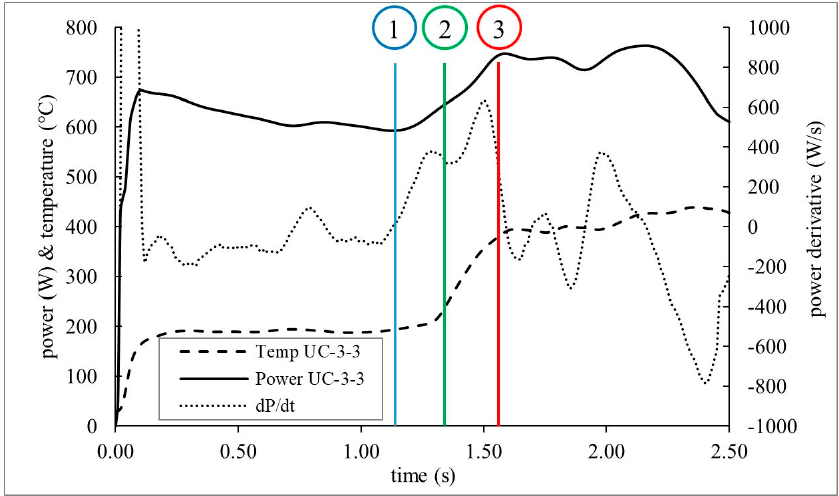
Figure 9. The time traces of the power, temperature, and the power derivative for the uncontrolled weld case C-3-3. The initiation of the second jump of the power and the temperature are marked as the blue (1) and the green (2) lines respectively. blue (1) and the green (2) lines